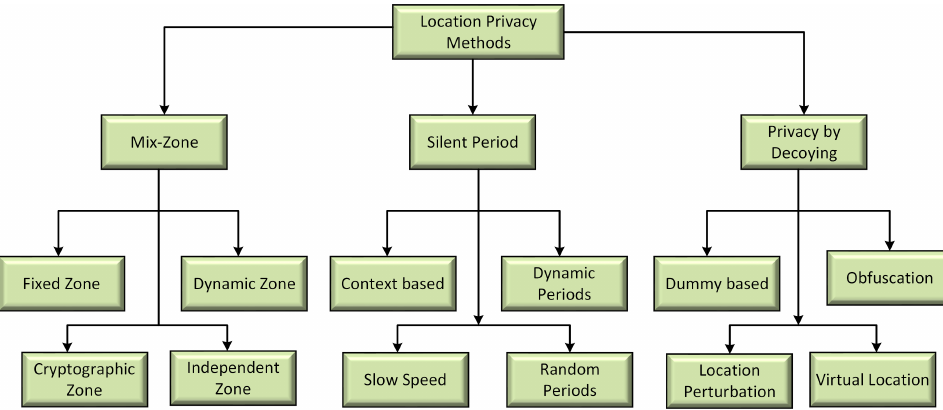
Figure 1. Location privacy protection techniques